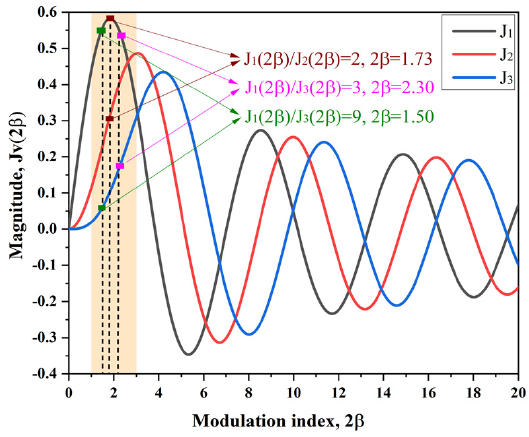
Figure 2. Bessel function and modulation index.